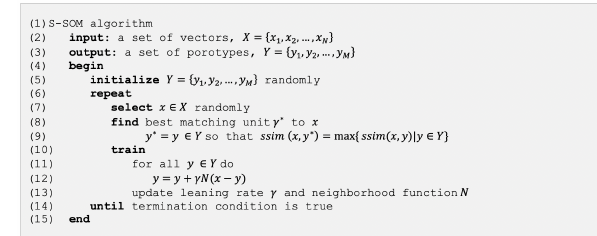
Figure 1. The S-SOM